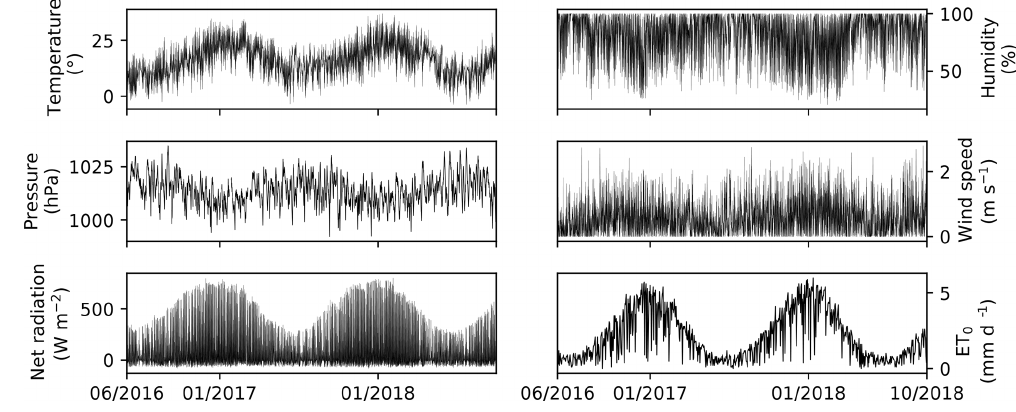
Figure 3. Meteorological time series at